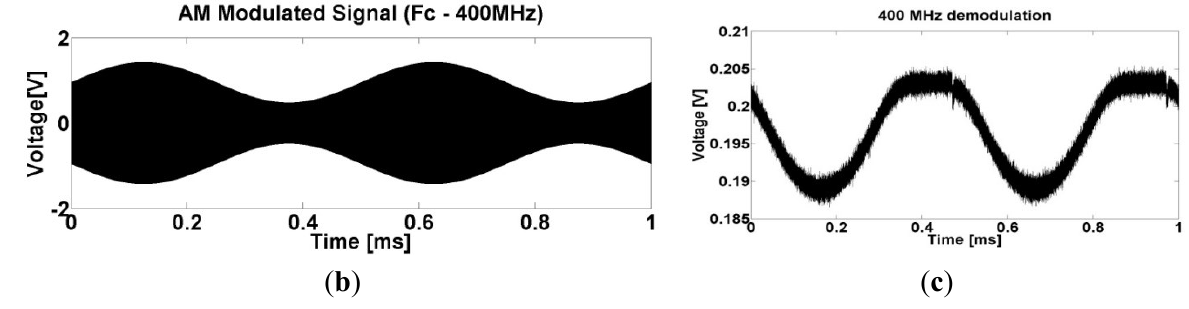
Figure 10. ( a ) GFET Demodulator ( b ) AM input and ( c ) Demod output (adapted from [17],